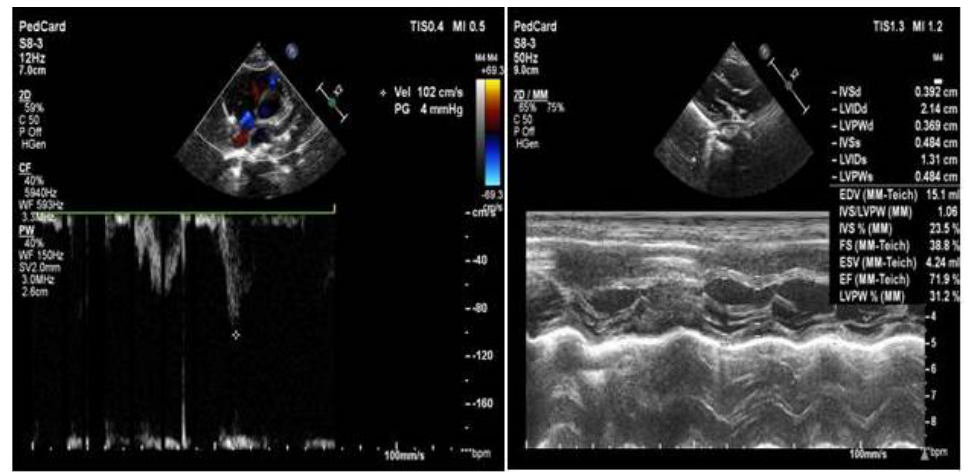
Figure 4. Child 2’s heart color ultrasound.